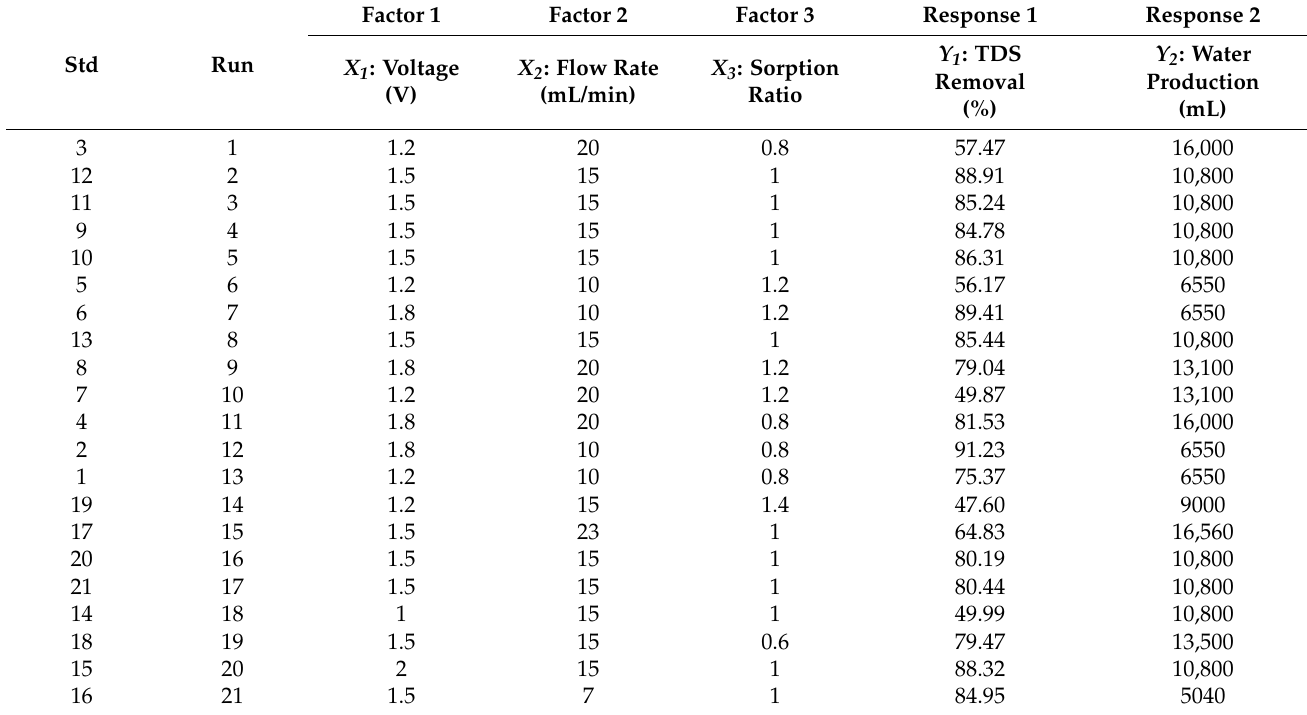
Table 4. Arrangement of response surface design.